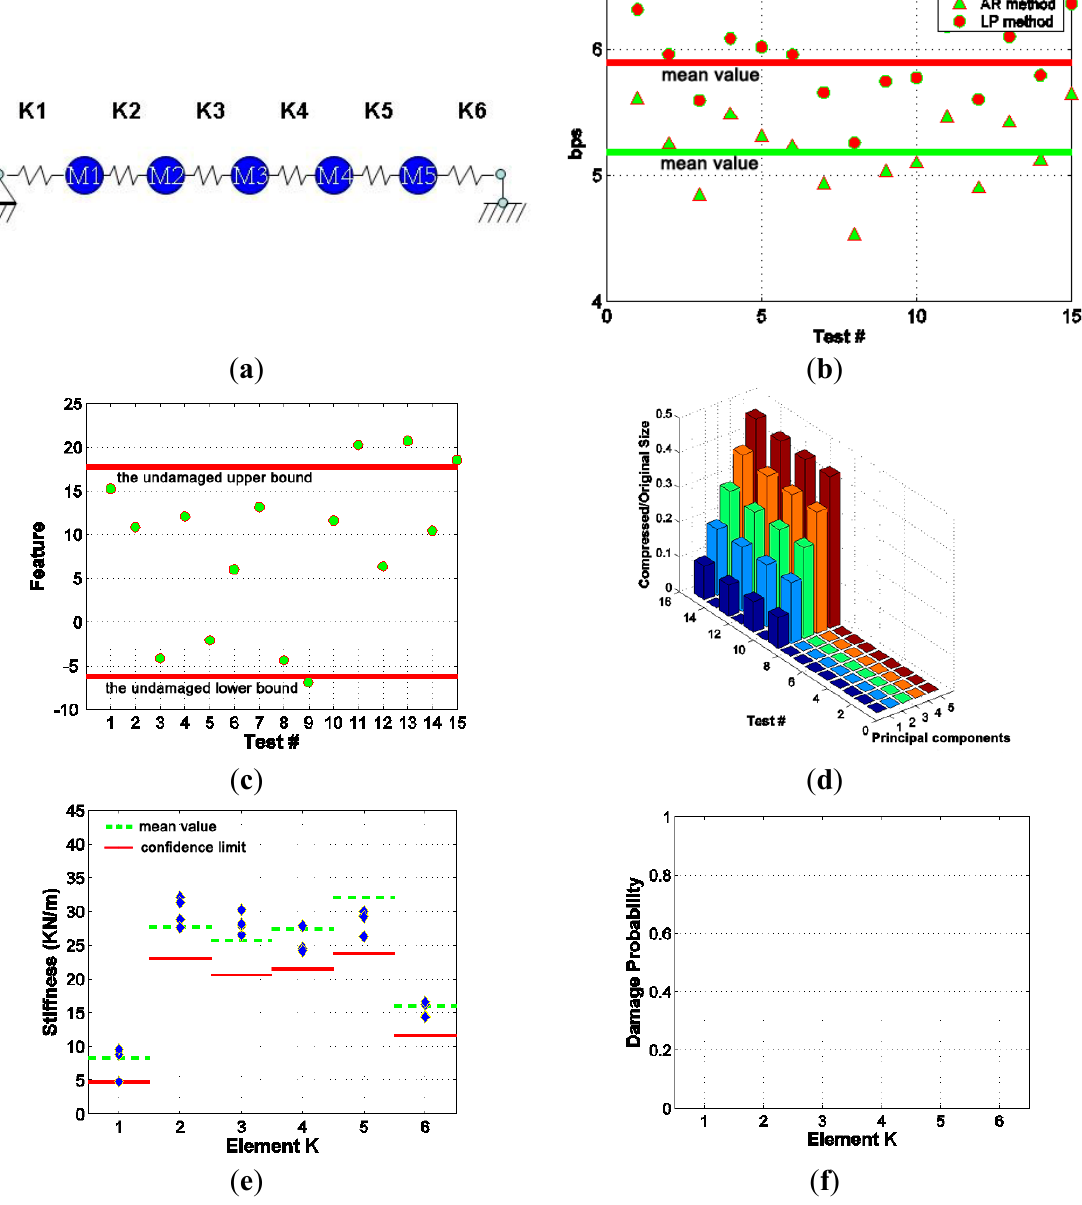
Figure 8. Performance of Integrated SHM system in Scenario #3 ( a ) Retrofitted structure (w/o damage); ( b ) Sensor data compression; ( c ) Feature monitoring; ( d ) Progressive data transmission; ( e ) Identified stiffness; ( f ) Statistical analysis of